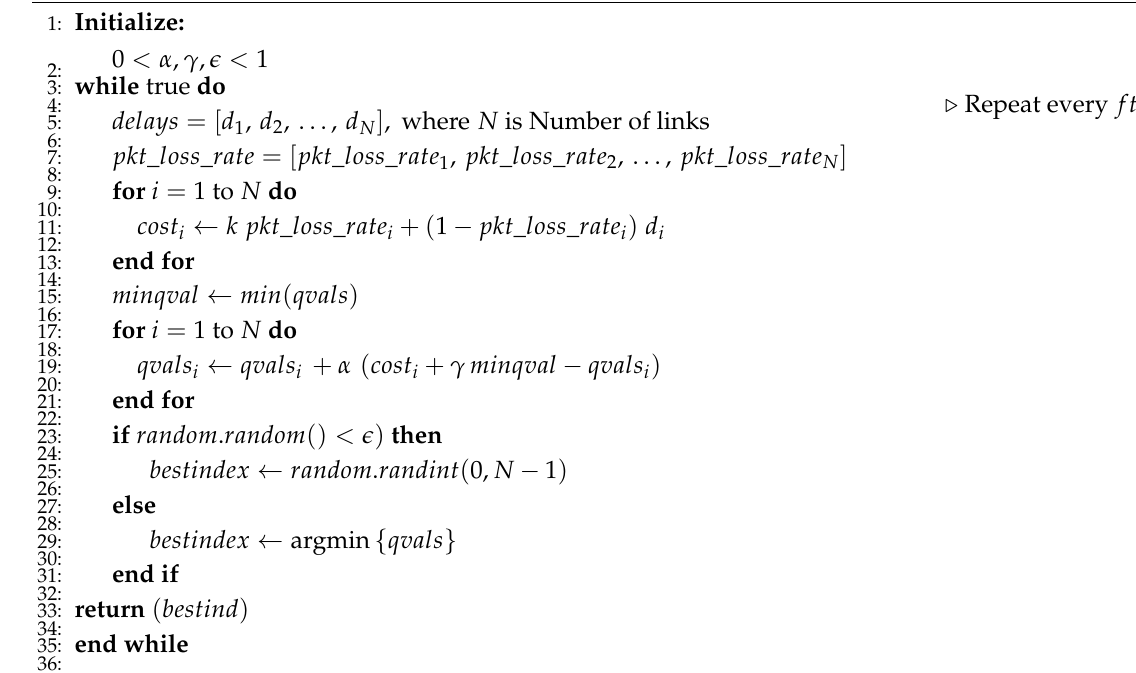
Algorithm 4 Latency and Packet-loss Optimized Q-Learning Link